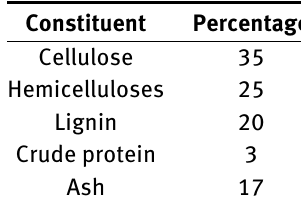
Table 1: Composition of rice husk